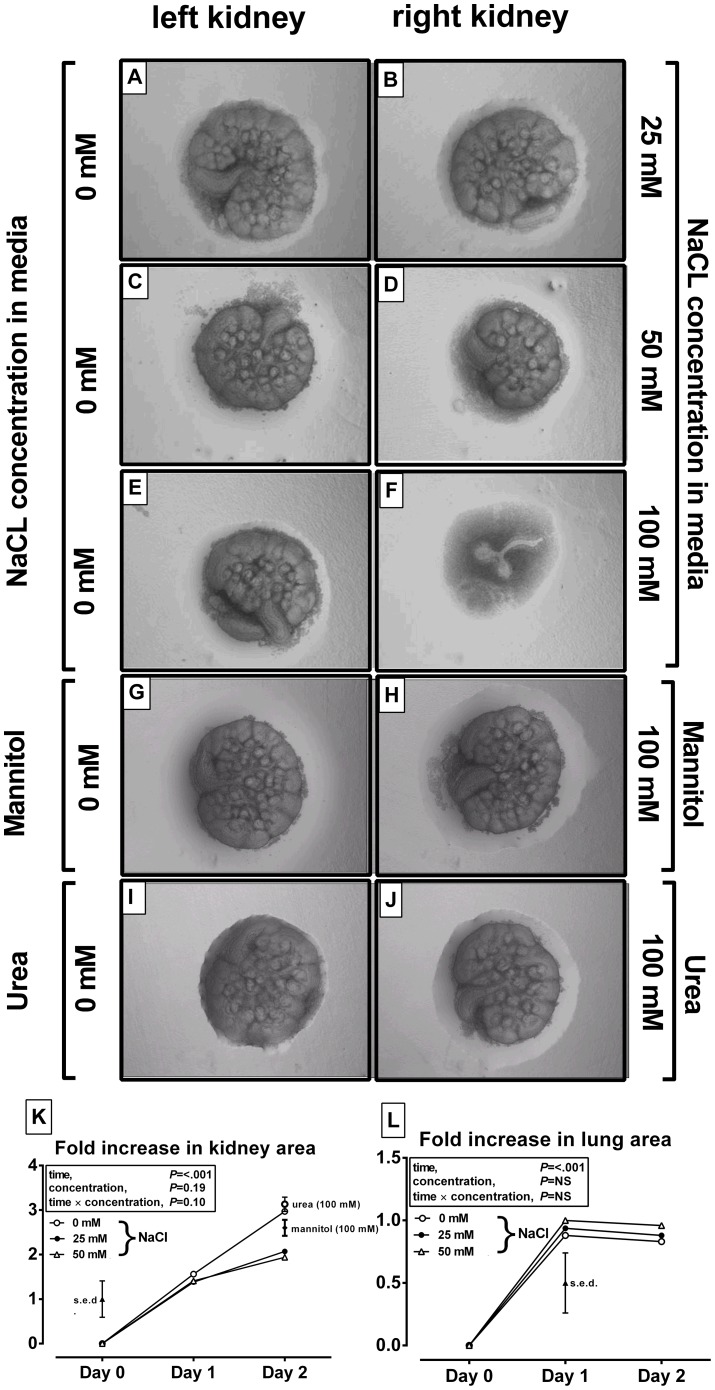
Increased extracellular salt blunts in vitro kidney but not lung development.
A–J: representative images of paired (left and right) kidneys (n = 4–6 replicates for analysis) cultured for 2 days in media with varying osmolality, generated using NaCl, mannitol or urea, at concentrations indicated on y-axes. K: growth (fold-increase in normalised surface area) of cultured kidneys or lungs (L). Estimated marginal means for data are presented after analysis by repeated measures general linear models with treatment (NaCl, mannitol or urea) and concentration (0, 25, 50, 100 mM) or specific interactions as fixed effects and time as a repeated measure (Genstat v14). The overall standard error of the difference (s.e.d.) between means for the statistical comparison is presented.